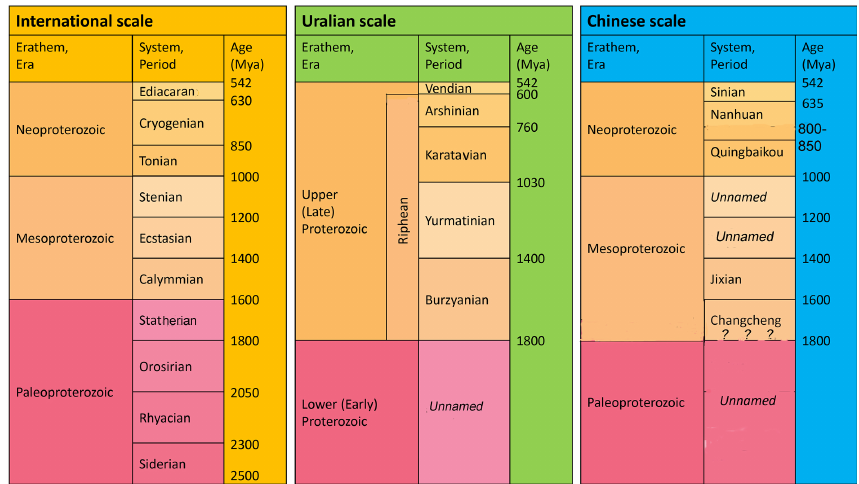
Figure 1. Correlation between the international stratigraphic Scheme of the Proterozoic (Gradstein and Ogg, 2012), the regional stratigraphic scheme of the Upper Proterozoic of the Urals (Uralian scale; Puchkov et al., 2014) and the geological timescale of the Proterozoic in China (Lu et al., 2008; Li et al.,